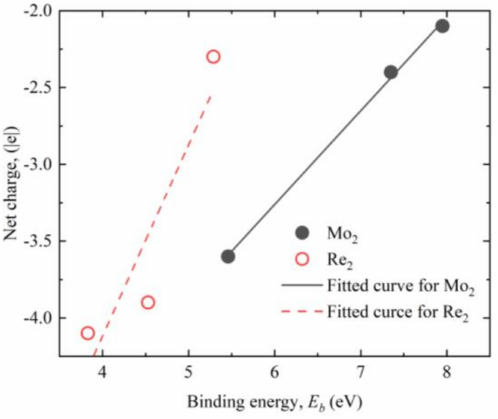
Figure 5. The relationship between the binding energy of the dimer and the net